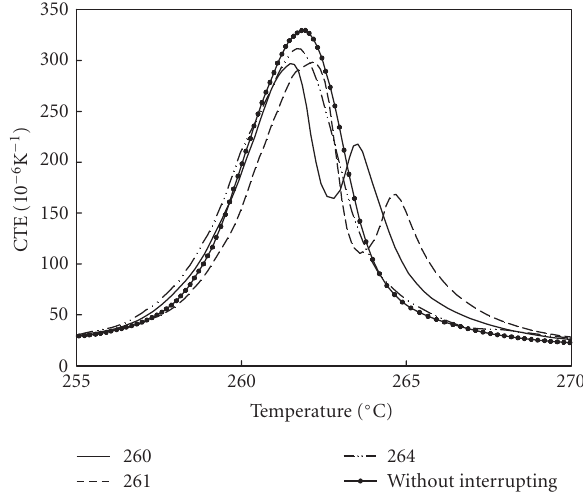
Figure 4: Temperature dependence of the relative elongation for Ni 53 . 6 Mn 27 . 1 Ga 19 . 3 alloy after an incomplete cycle.